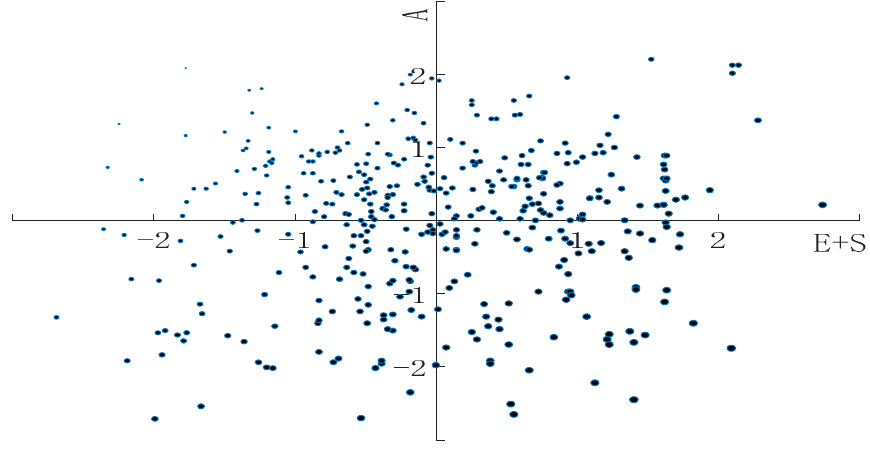
Figure 5. Classification of employee livelihood vulnerability in relocation enterprises.